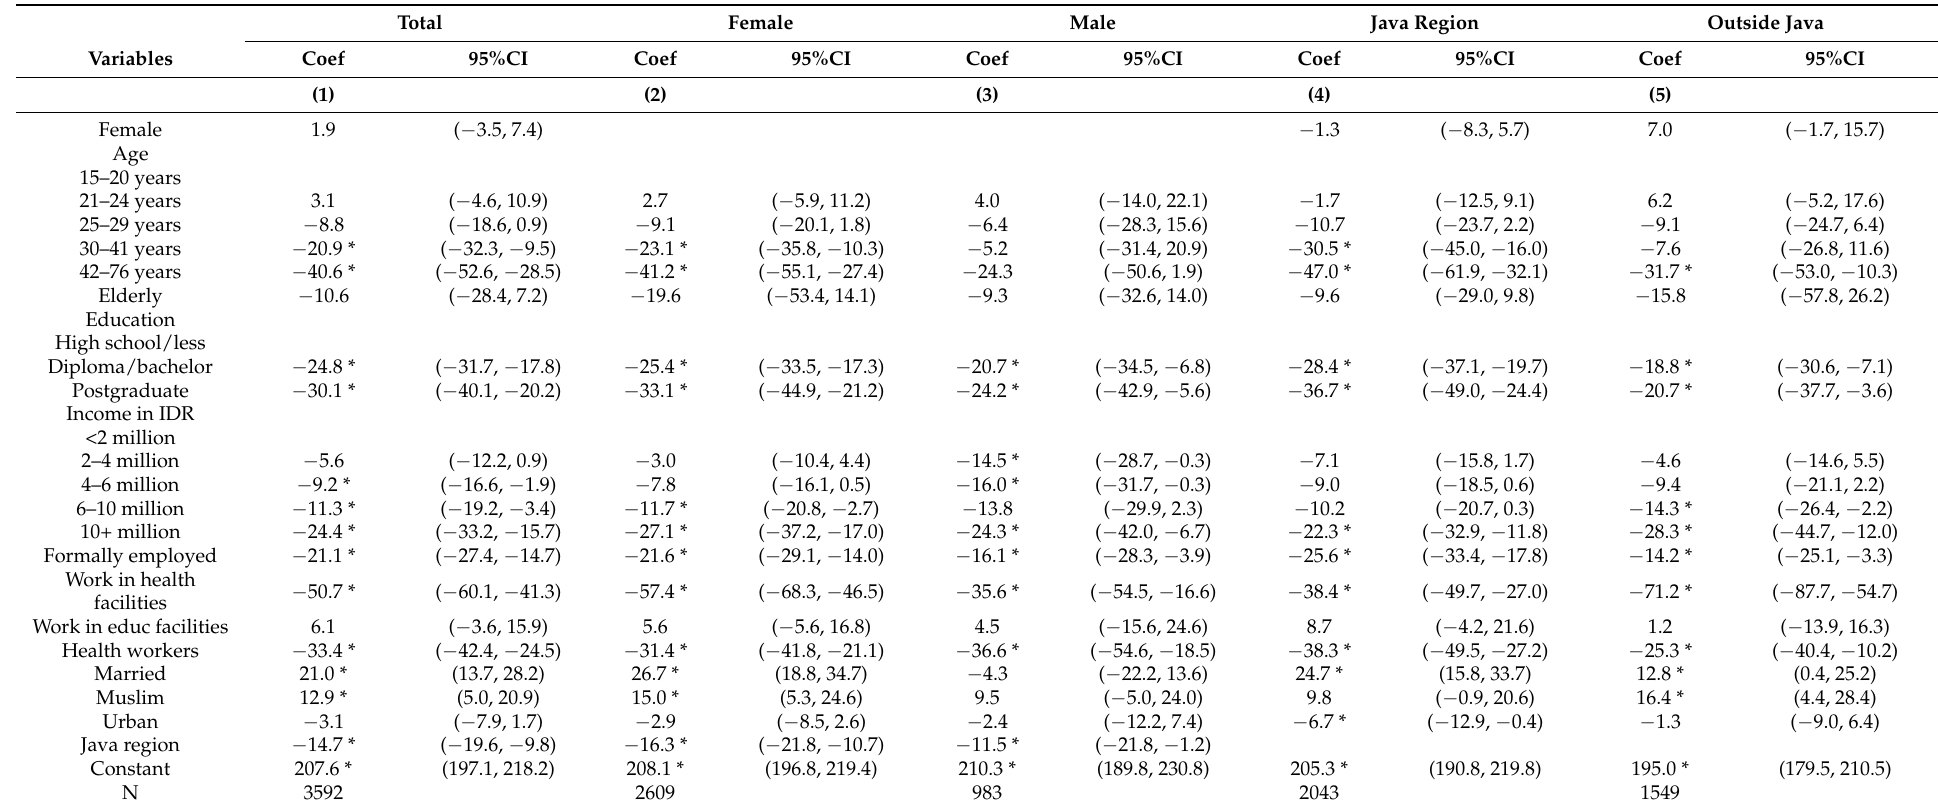
Table 3. Socioeconomic and geographic inequalities in days to receive the COVID-19 vaccine: first